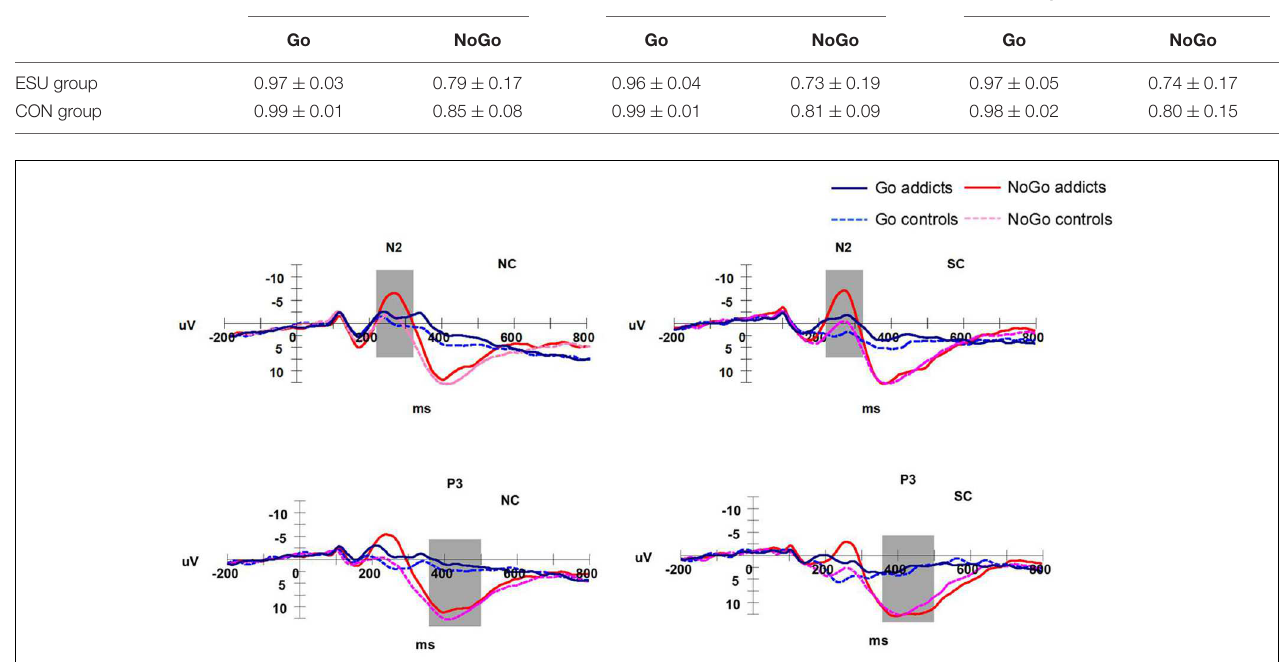
FIGURE 4 | The ERP waveforms at FCz and CPz electrode